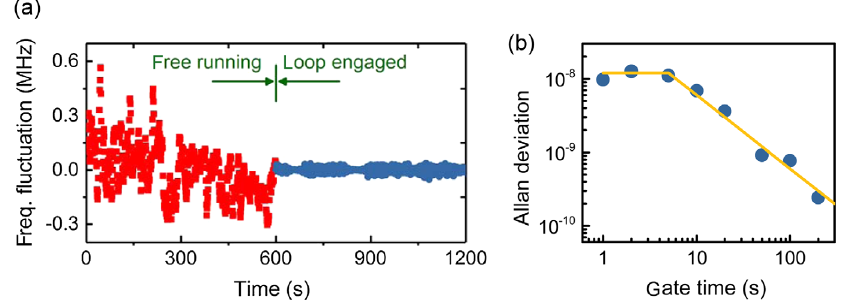
FIG. 5. (a) Long-term frequency fluctuation of the first sideband with respect to the pump engaging (blue) and without engaging (red) the computer-aided slow feedback control, counted with a gate time of 1 second. (b) Allan deviation of the stabilized THz frequency, measuring a plateau of 1 . 2 × 10 − 8 for gate times shorter than 5 seconds and a roll-off of 6 × 10 − 8 = τ for longer gate times.